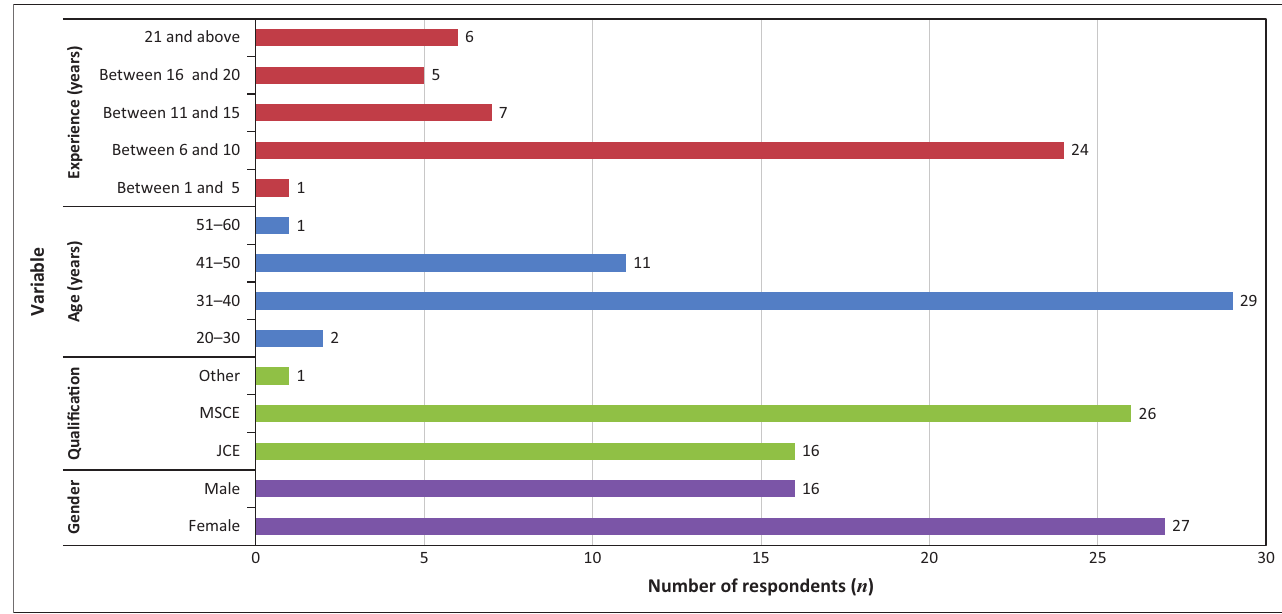
FIGURE 1: Background information of respondents ( n =